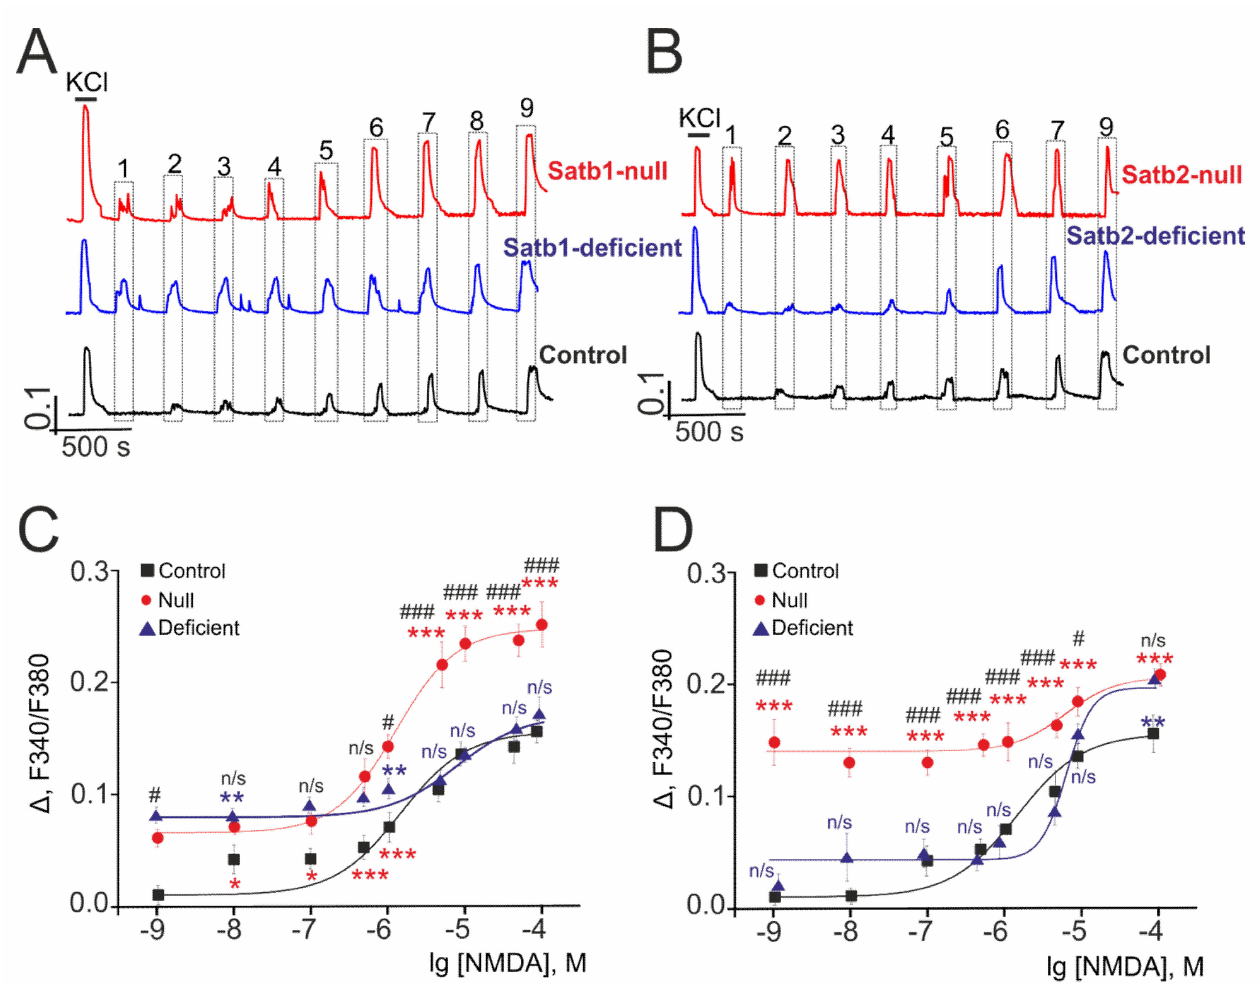
Figure 4. The effect of deletion in the transcription factors Satb1 and Satb2 on the Ca 2+ -signals produced by cortical neurons after activation of NMDA-receptors. ( A , B) application of NMDA in Mg 2+ -free medium to the neurons of brain cortex isolated from the Satb1- ( A ) and Satb2- knockout mice ( B ). ( C , D ) dependence of the Ca 2+ -responses amplitude on NMDA concentration in the brain cortex neurons of the Satb1 ( C ) and Satb2 ( D ) knockout mice. NMDA concentrations are specified with horizontal lines accompanied with correspondent cyphers: 1–0.001, 2–0.01, 3–0.1, 4–0.5, 5–1, 6–5, 7–10, 8–50, 9–100 µ M. For each concentration, average data are represented, obtained from several hundreds of neurons in 5 independent experiments ± SEM. For panels ( A , B ), averaged Ca 2+ -responses for neurons from individual experiments are represented. For panels ( A , B ), we analyzed 200 cells ( n = 200) in each experiment. For panels ( C , D ), every experiment was repeated six times ( n = 6) using cell cultures from separate passages. Statistical analyses were performed by two-way ANOVA, followed by Sidak’s multiple comparison test. * p < 0.05, ** p < 0.01, and *** p < 0.001 comparing Satb-deficient group (blue asterisk) and Satb-null group (red asterisk) with control mice; # p < 0.05 and ### p < 0.001 comparing Satb- deficient group with Satb-null group; n/s (blue) and n/s (black)—data not significant in experimental Satb-deficient group compared to control mice, and Satb-deficient group compared to Satb-null group,